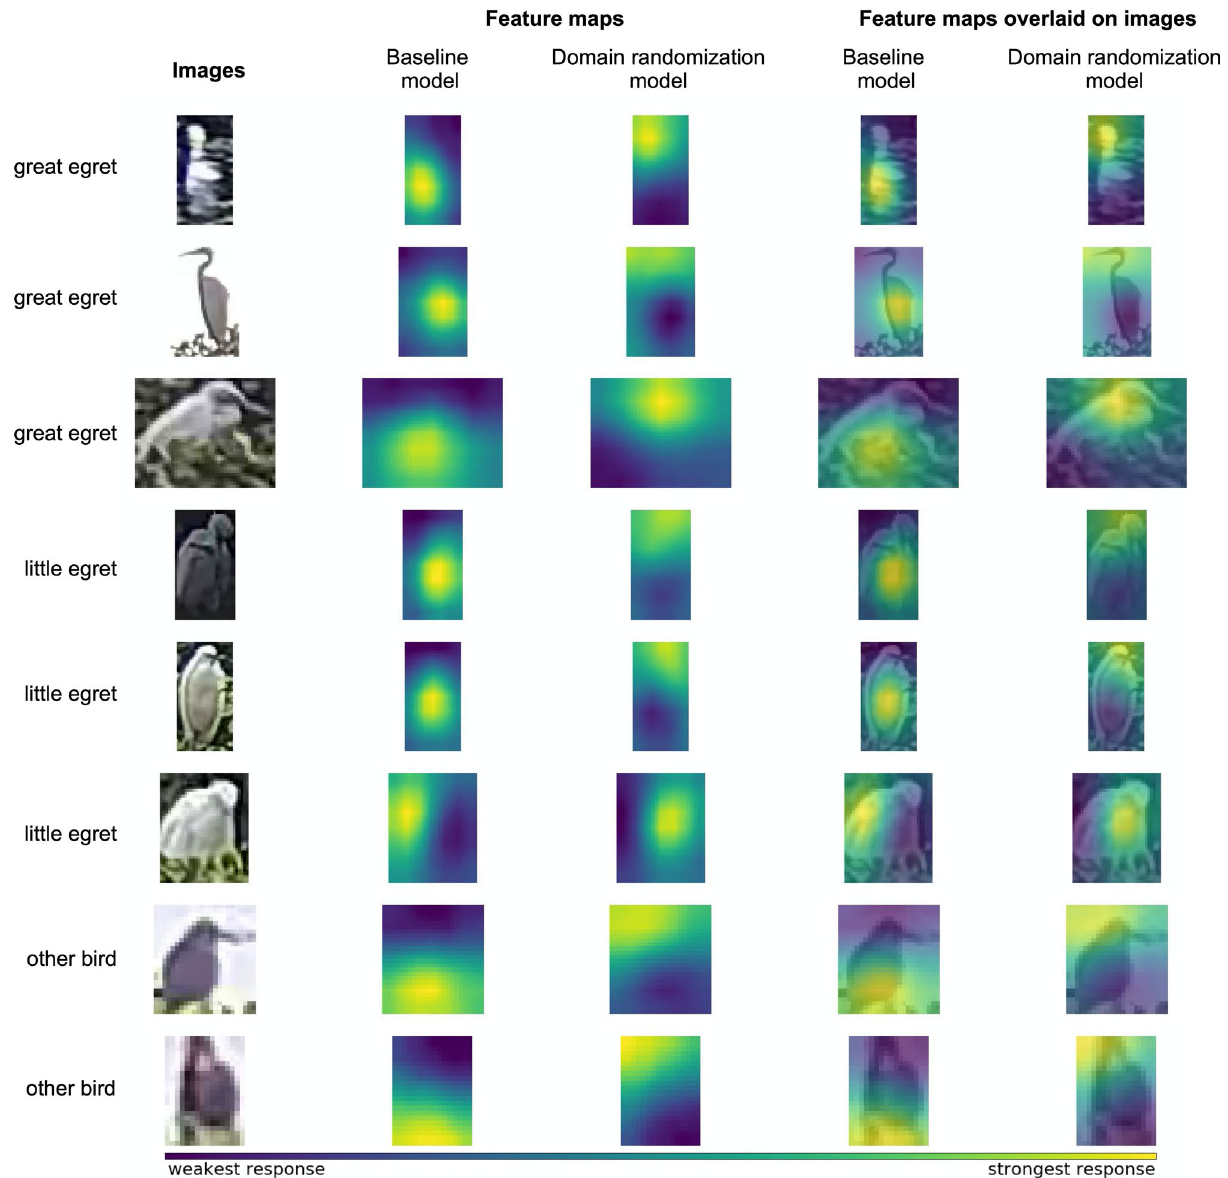
Figure 5. Visualization of the perception made by detection models for distinguishing bird species. We compared our proposed method with the same architecture that is trained with real images only (known as the baseline model). For examples of different bird species (first column), the feature maps (response of the model) of the baseline model and domain randomization-enhanced model are shown in second and third column, respectively. The viridis colormap is used to illustrate the intensity of the response, where yellow represents the strongest response. The feature maps are overlaid on the bird images to depict the features used by the baseline model (forth column) and the domain randomization-enhanced model (fifth column) for bird detection. We realize that model pretraining with the synthetic images forces the model to focus on the fine-grained features, such as neck shape and beak color, which are the crucial features used by experts for bird (not the body size represented in images, which is influenced by the distance to the camera). Furthermore, we split the testing periods according to the trends observed in the bird counts (Fig. 6a) to identify the spatial change of the egret hotspots (Fig. 7b). For great egrets, the hotspot near the middle right region of the trees remains relatively constant in size and intensity, whereas the hotspots at the top of the trees (vulnerable to wind) shrink and grow over time, and similar changes are observed for the little egrets. Based on the aerial view (Fig. 1b), we observe that the hotspots (at the middle right region of Fig. 7b) are sheltered from wind/gales in the north/ south direction, which renders this location a favorable habitat for egrets to inhabiting, breeding and hatching. We attempted to probe the relationship between weather factors and bird activities (reflected from the bird counts) by building a multivariable linear regression model. The weather data were collected from the Hong Kong Observatory Open Data 54 . We used the natural logarithm of the total bird counts to reflect its proportional